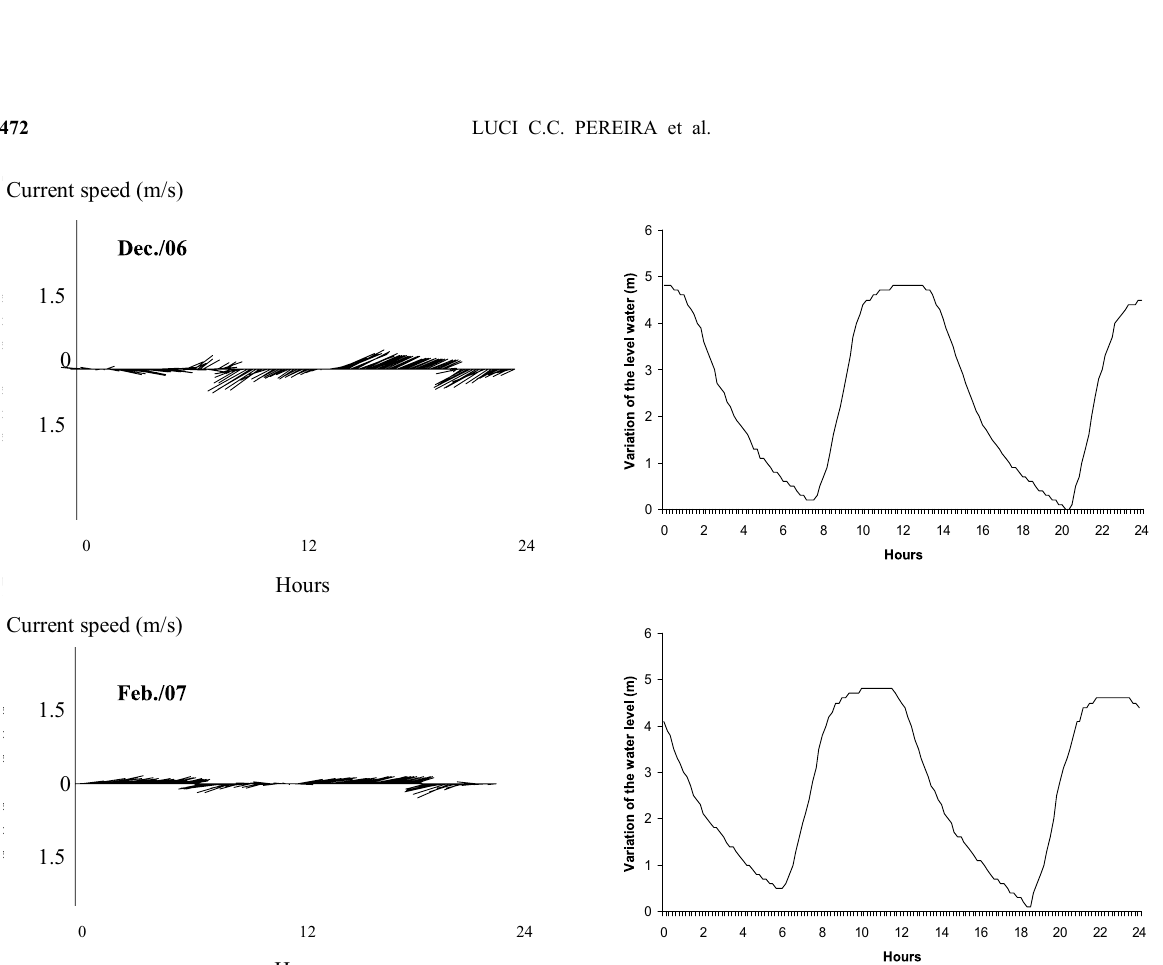
Fig. 2 (Continuation) – Hydrodynamic data recorded between April/06 and February/07, during spring tides, in the Caeté